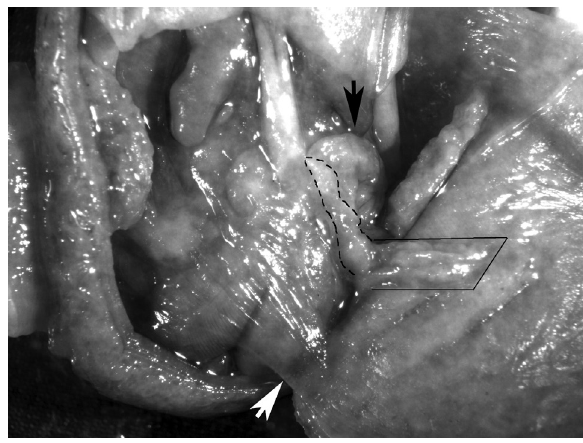
Fig . 4. – Mantle cavity of Sepiola bursadhaesa n. sp., holotype, MNCN 15.06/226H, female. The white arrow points to the border of the velum, the black arrow indicates the bursa copulatrix, the solid line encompasses the rearmost strip of the bursa copulatrix that broke off and remained attached to the inner mantle wall, following the cutting and turning open of the mantle ventral side; the broken line surrounds the scar left on the bursa copulatrix.